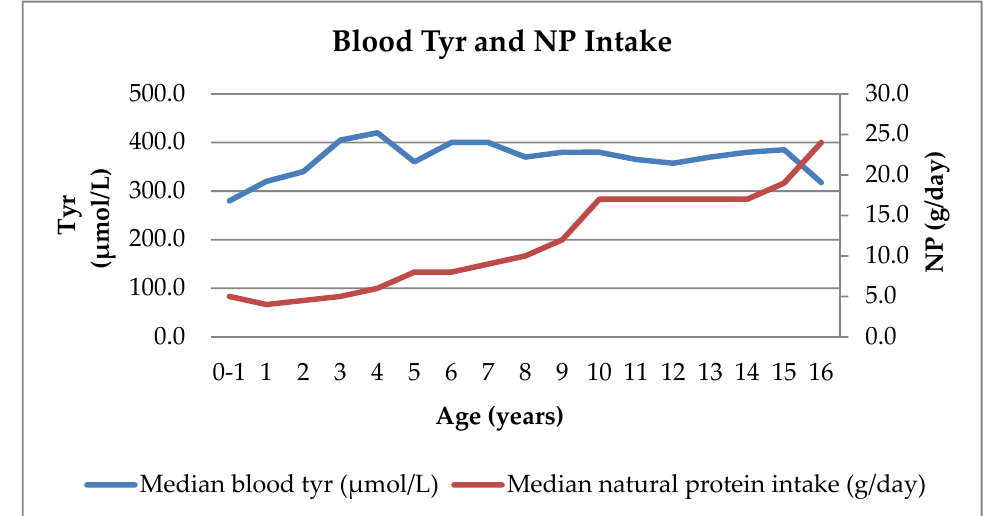
Figure 3. Median blood Tyr concentrations and NP intake by age in patients with HTI.